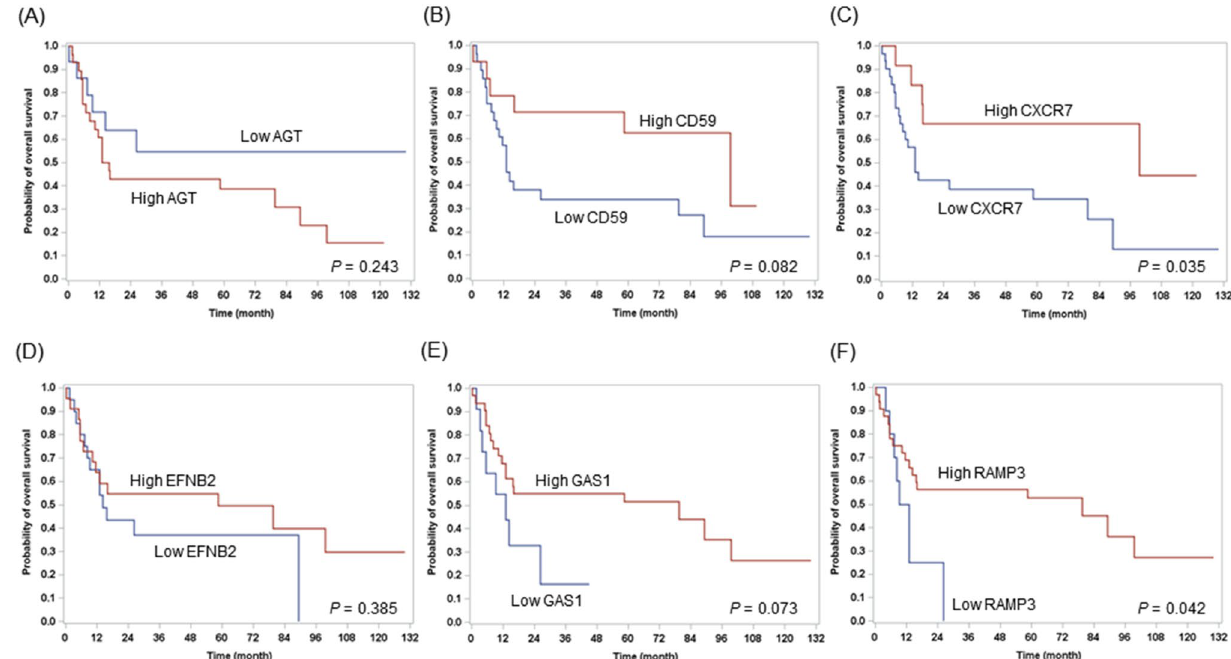
Figure 4. Kaplan–Meier survival curves for ENKTL patients based on gene expression of 6 genes including AGT ( A ), CD59 ( B ), CXCR7 ( C ), EFNB2 ( D ), GAS1 ( E ), and RAMP3 ( F ). ENKTL, extranodal natural killer T-cell